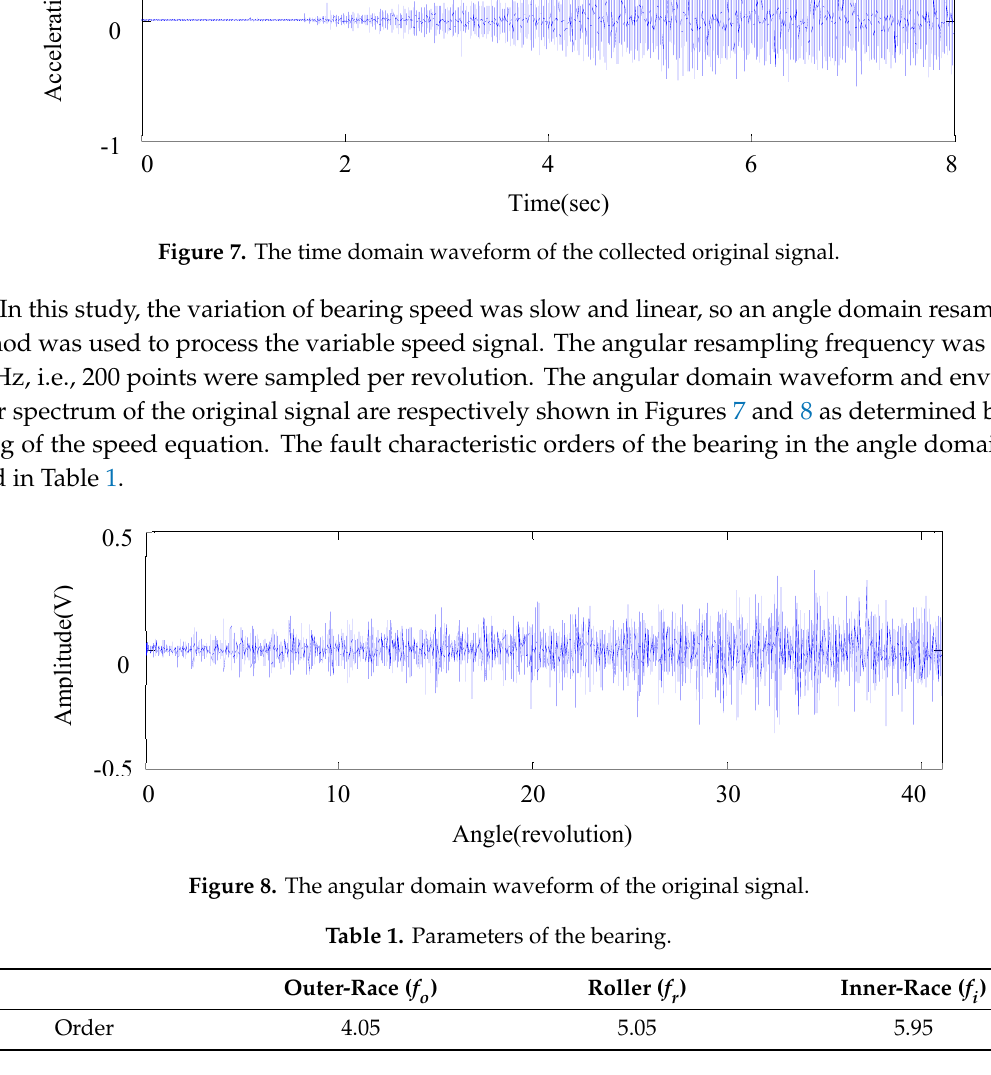
Figure 9. Envelope order spectrum of the original signal. Table 1. Parameters of the bearing.